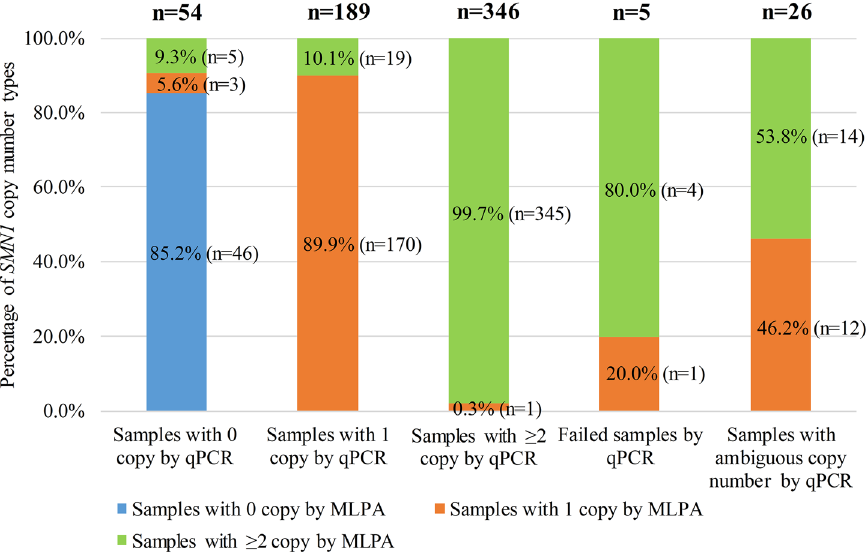
Figure 1. The results of qPCR. A total of 620 reactions were implemented for the 478 samples and 142 repetitions of the 71 repeatability study samples with qPCR. With qPCR method, 26 reactions results were as ambiguous copy numbers, 5 reactions failed, 54 reactions results were 0 copy SMN1 gene, 189 reactions results were 1 copy SMN1 gene, and 346 reactions results were ≥ 2 copies SMN1 gene, each of which is shown as a bar chart. In each bar chart, the samples that were analyzed as 0 copy, 1 copy and ≥ 2 copies of SMN1 gene with MLPA method are shown as the blue, orange and green,